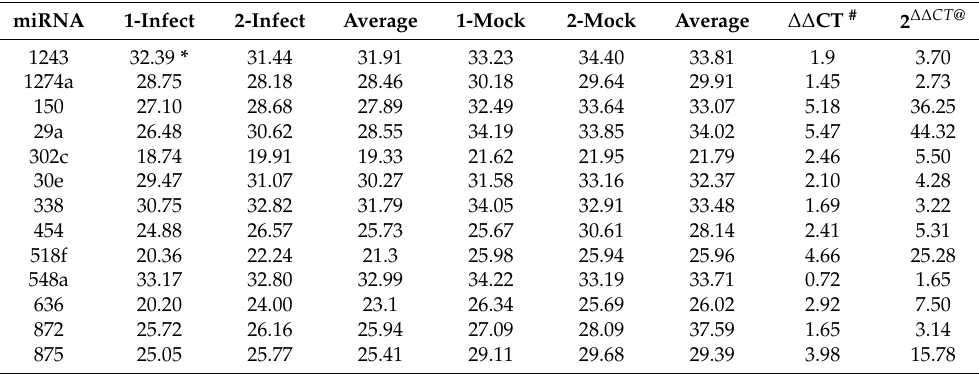
Table 2. CT * values for miRNAs upregulated in HIV-1 infected cell exosomes. miRNA 1-Infect